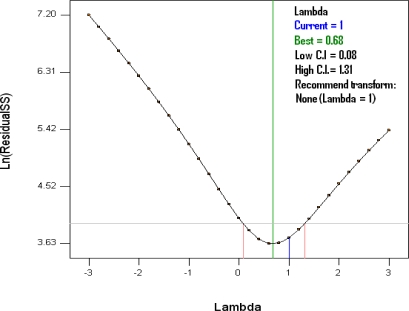
Box-Cox plot for power transformations (Yλ).